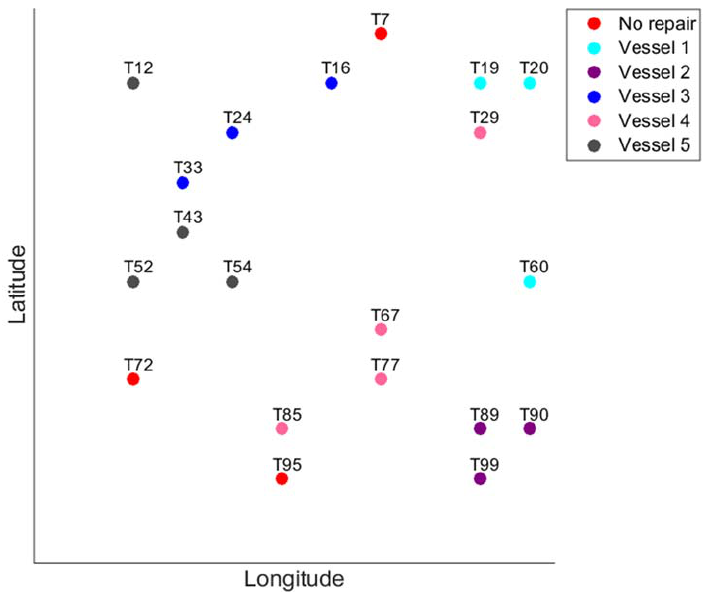
Figure 4 . Vessel dispatch plan for Case 3. Figure 4. Vessel dispatch plan for Case 3.